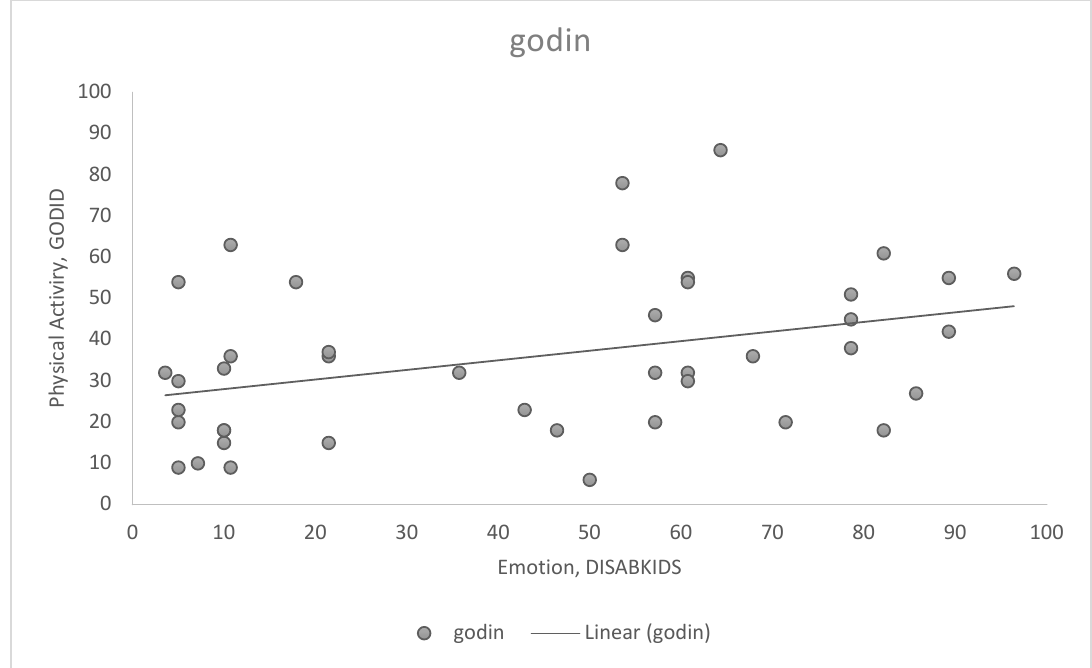
Figure 3. Patients with higher physical activity showed better emotional health (r: 0.414, p : 0.006).